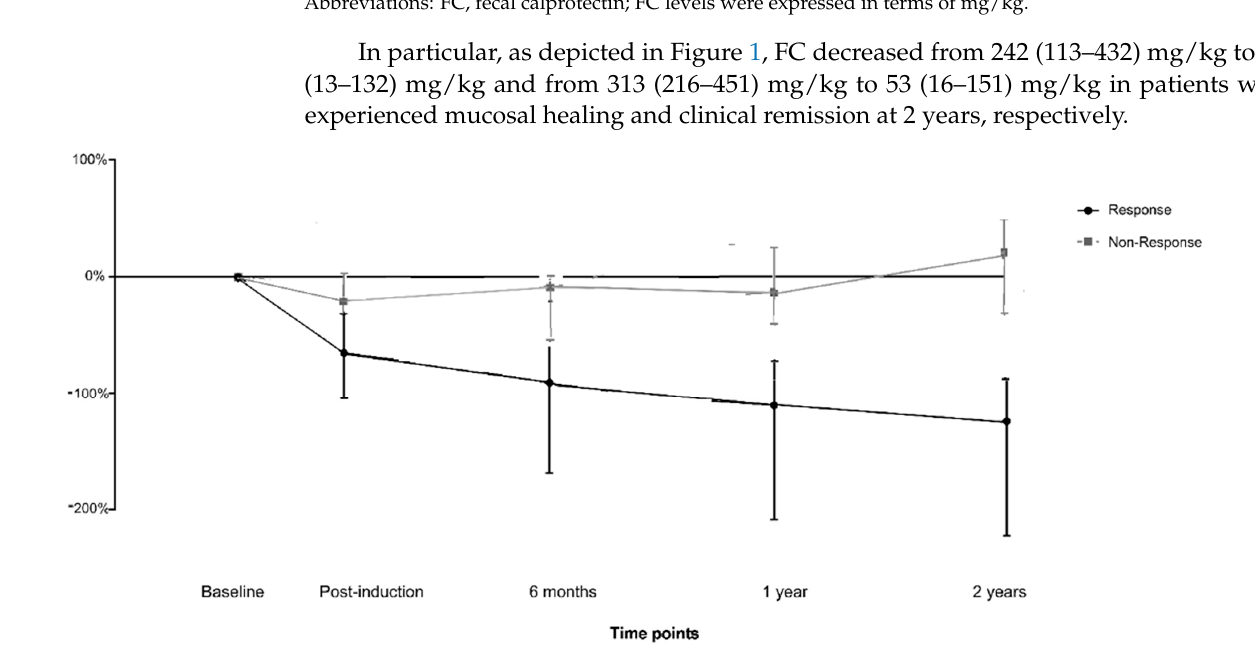
Figure 1. Kinetics of fecal calprotectin levels in responders and non-responders at different consecu- tive time-points .